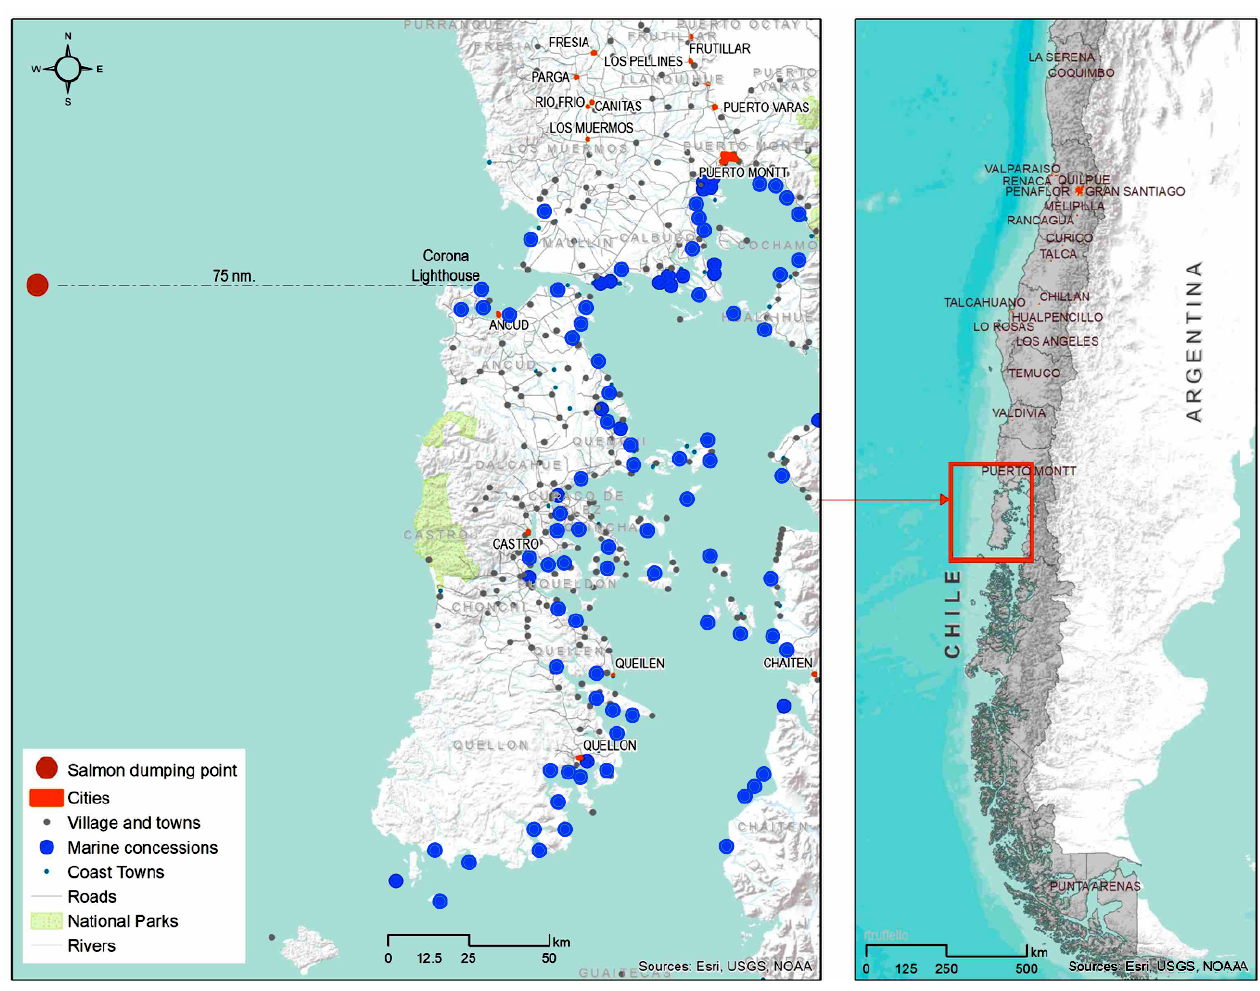
Fig. 1 . Chiloe Island,